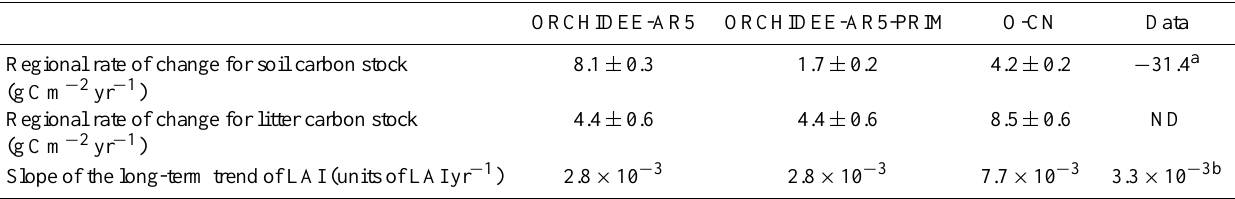
Table 1. Estimated rates observed and calculated by the different version of ORCHIDEE-AR5 from regional simulations over England and Wales (mean ± sd) for the period